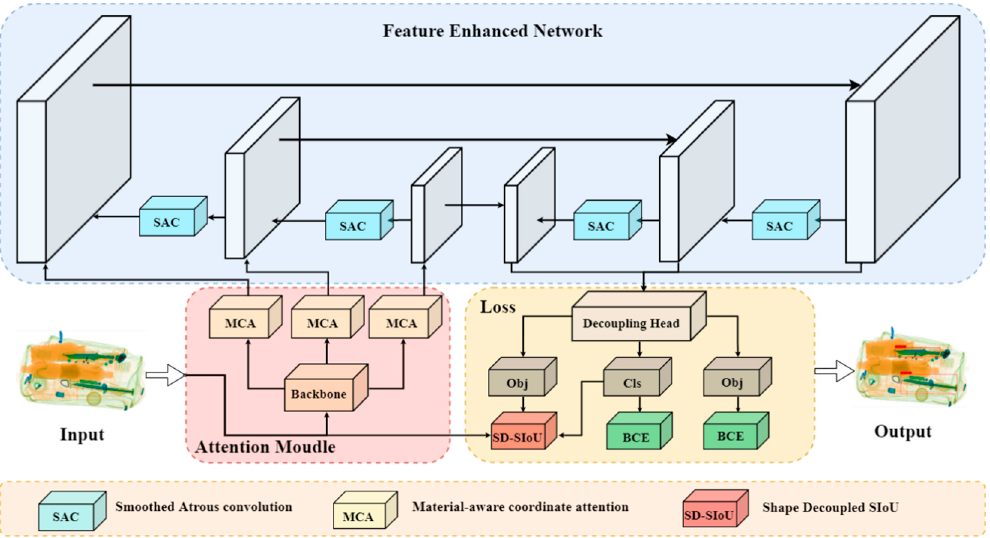
Figure 2. Overall architecture diagram. The network backbone for the feature extraction is CSP- Darknet53, which is the same in the detection network. The feature-enhanced network is a path aggregation network with a SAC module.